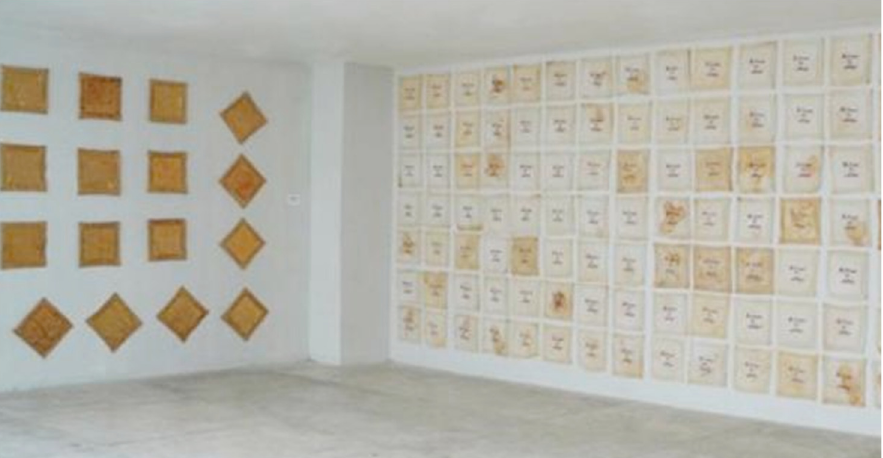
Figure 3. Jessica Sofía Mitrani, At least I Entertain Myself (2011). Image provided by the artist.